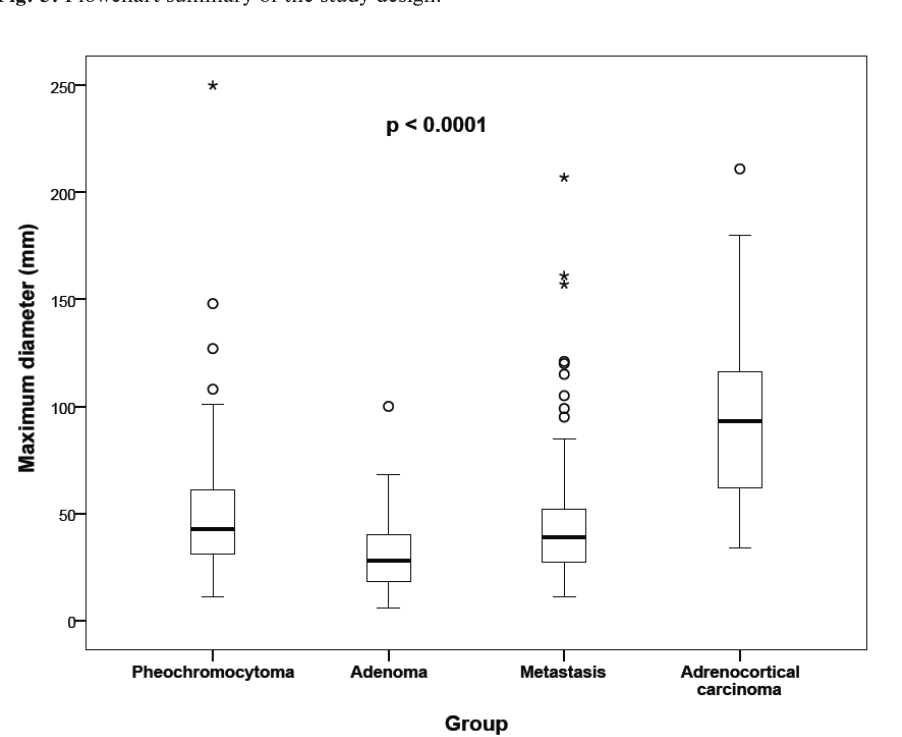
Fig. 6. Maximum diameter of adrenal masses in different histological groups. The thick line represents the median, the bottom of the box stands for the first quartile, the top of the box for the third quartile, and the whiskers display the minimum and maximum non-distant values. The circles represent outliers and stars show extreme